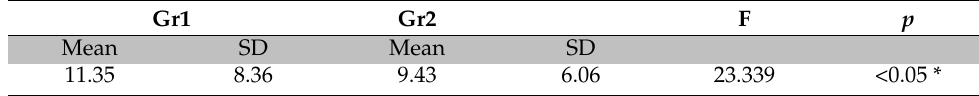
Table 9. Effect of between factor (group) on task 3 (ESPE).